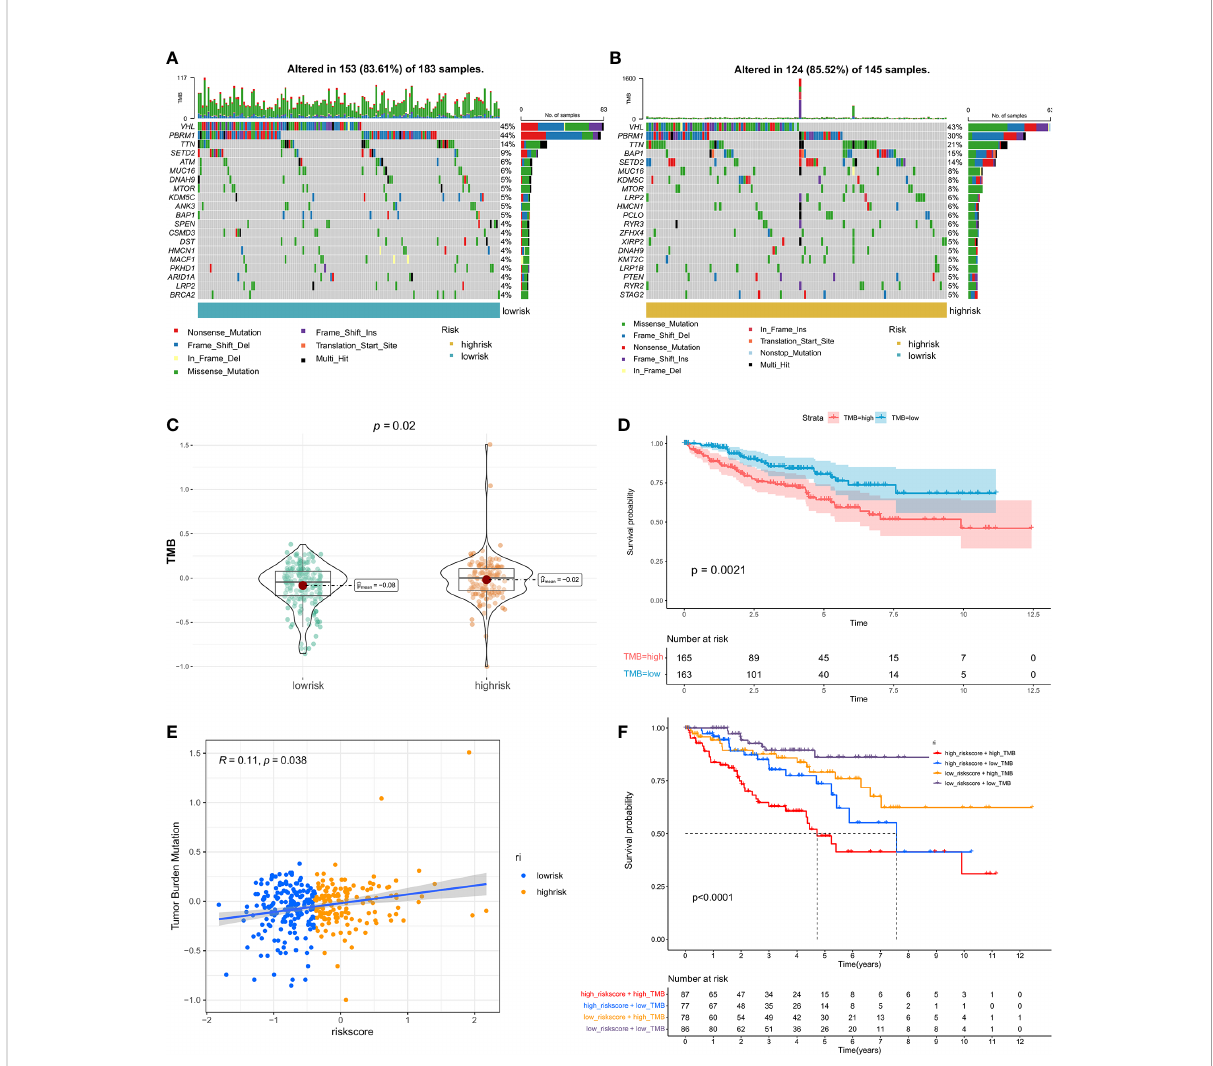
FIGURE 5 The correlation between TMB and riskscore: Genomic mutation status in the low-risk (A) and high-risk (B) groups is shown via a waterfall graphic. (C) The difference in TMB between groups with high- and low-risk. (D) The PFS survival curve between the high- and low-TMB groups. (E) Correlation analysis of riskscore and TMB. (F) Graphs showing Kaplan-Meier survival curves for four subgroups strati fi ed by risk scores and